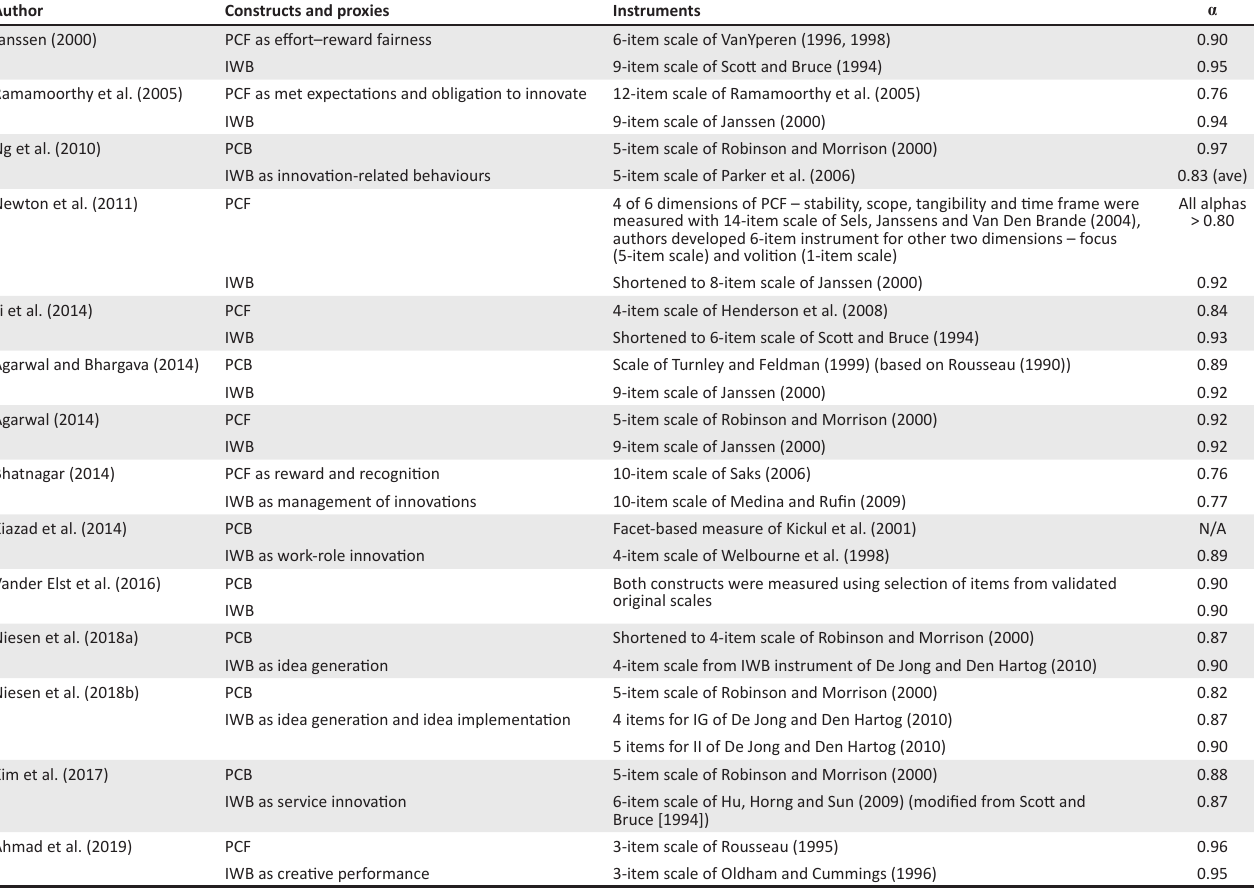
TABLE 2: Measurement of innovative work behaviour and psychological contract breaches and their